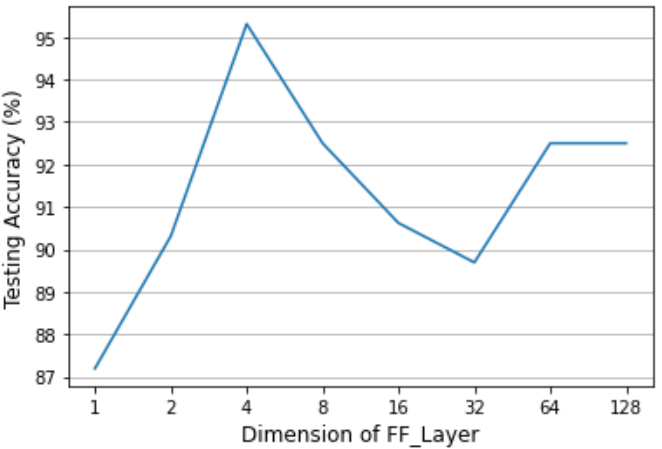
Figure 10. The influence of the dimensions of the feedforward layer.